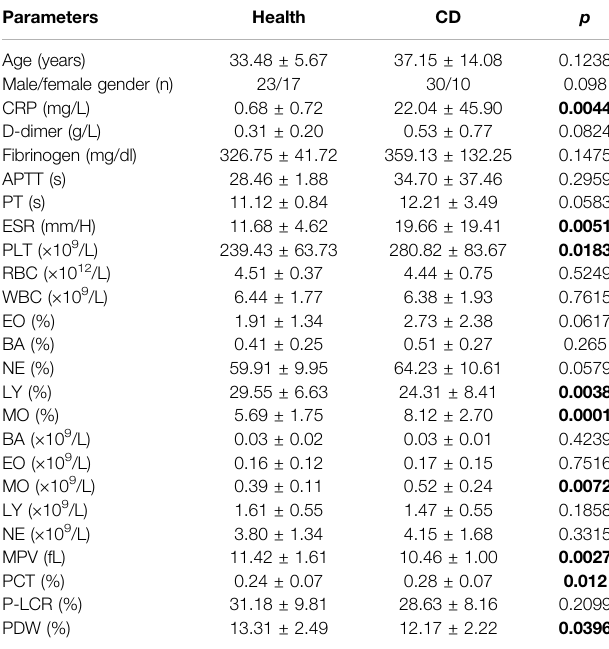
TABLE 1 | Baseline characteristics and laboratory fi ndings in healthy controls and patients with active Crohn ’ s disease (CD).